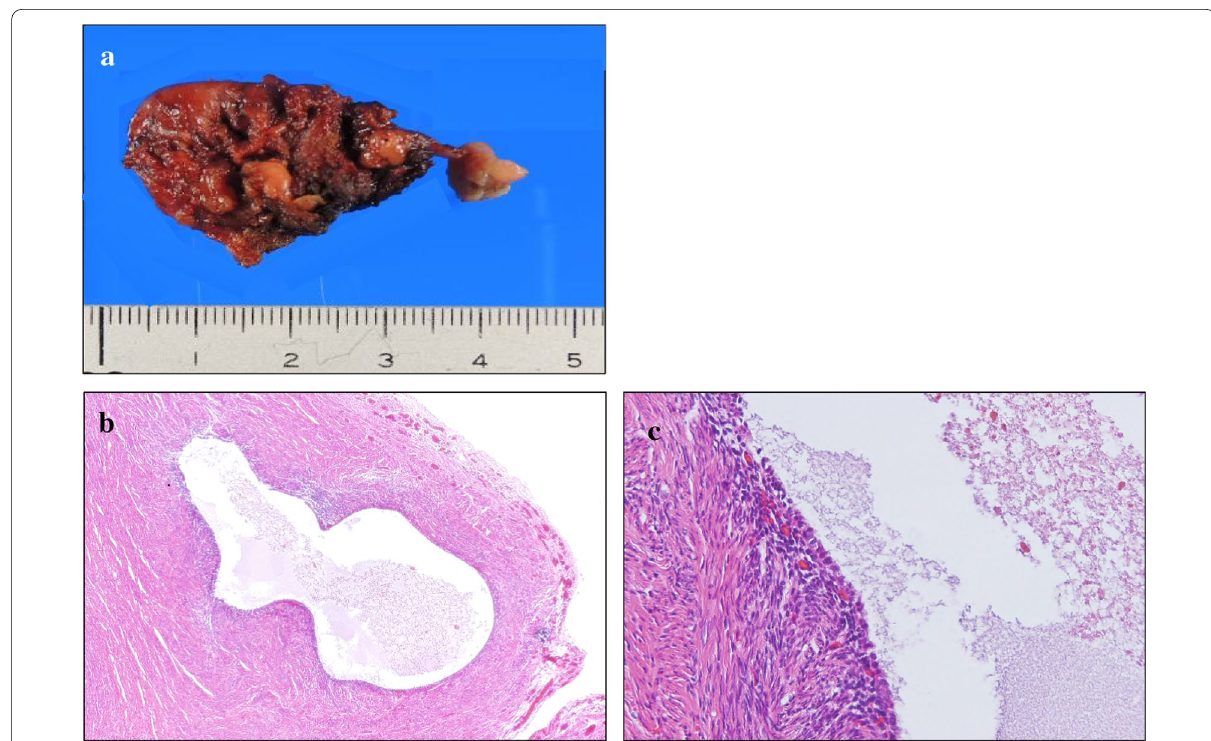
Fig. 3 Resected specimen and pathological results. a A macroscopic examination showed that the resected specimen was a 4 with no obvious effusion. b The hydrocele consisted of muscle tissue, fibrous tissue, a small amount of adipose tissue, and dilated blood vessels